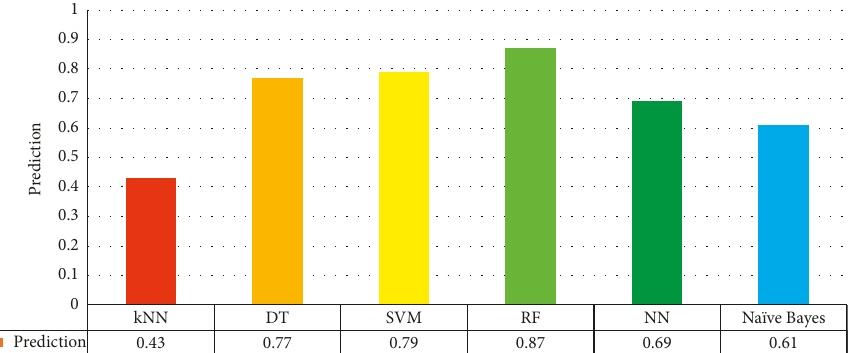
Figure 18: Graphical representation of prediction of low noise level using different ML models for the input instances with probability values